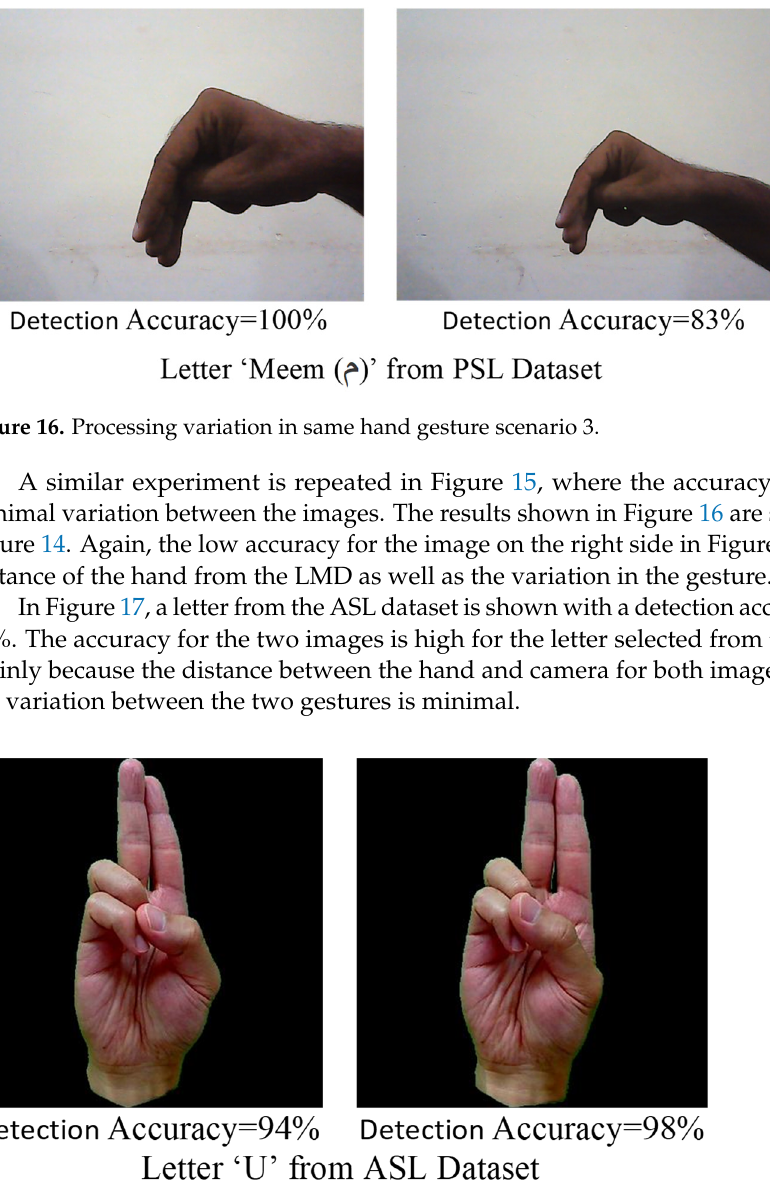
Figure 15. Processing variation in same hand gesture scenario 2.